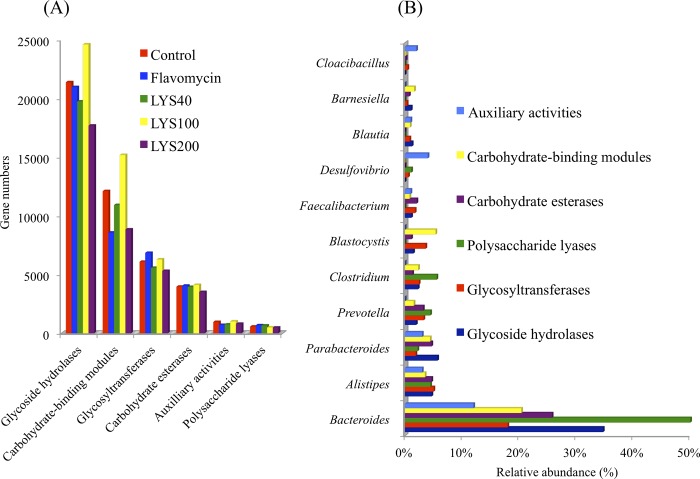
Expression and classification of carbohydrate-active enzymes in the cecal microbiota of broilers fed a corn-based diet supplemented with 0 (control), 40 (LYS40), 100 (LYS100), or 200ppm (LYS200) lysozyme or 400 ppm flavomycin.(A) Expression of carbohydrate-active enzyme genes in the cecal microbiota of broilers with different dietary treatments. (B) Taxonomy and relative abundances of the classifiable carbohydrate-active enzyme genes identified in cecal microbiota of broilers with different dietary treatments.